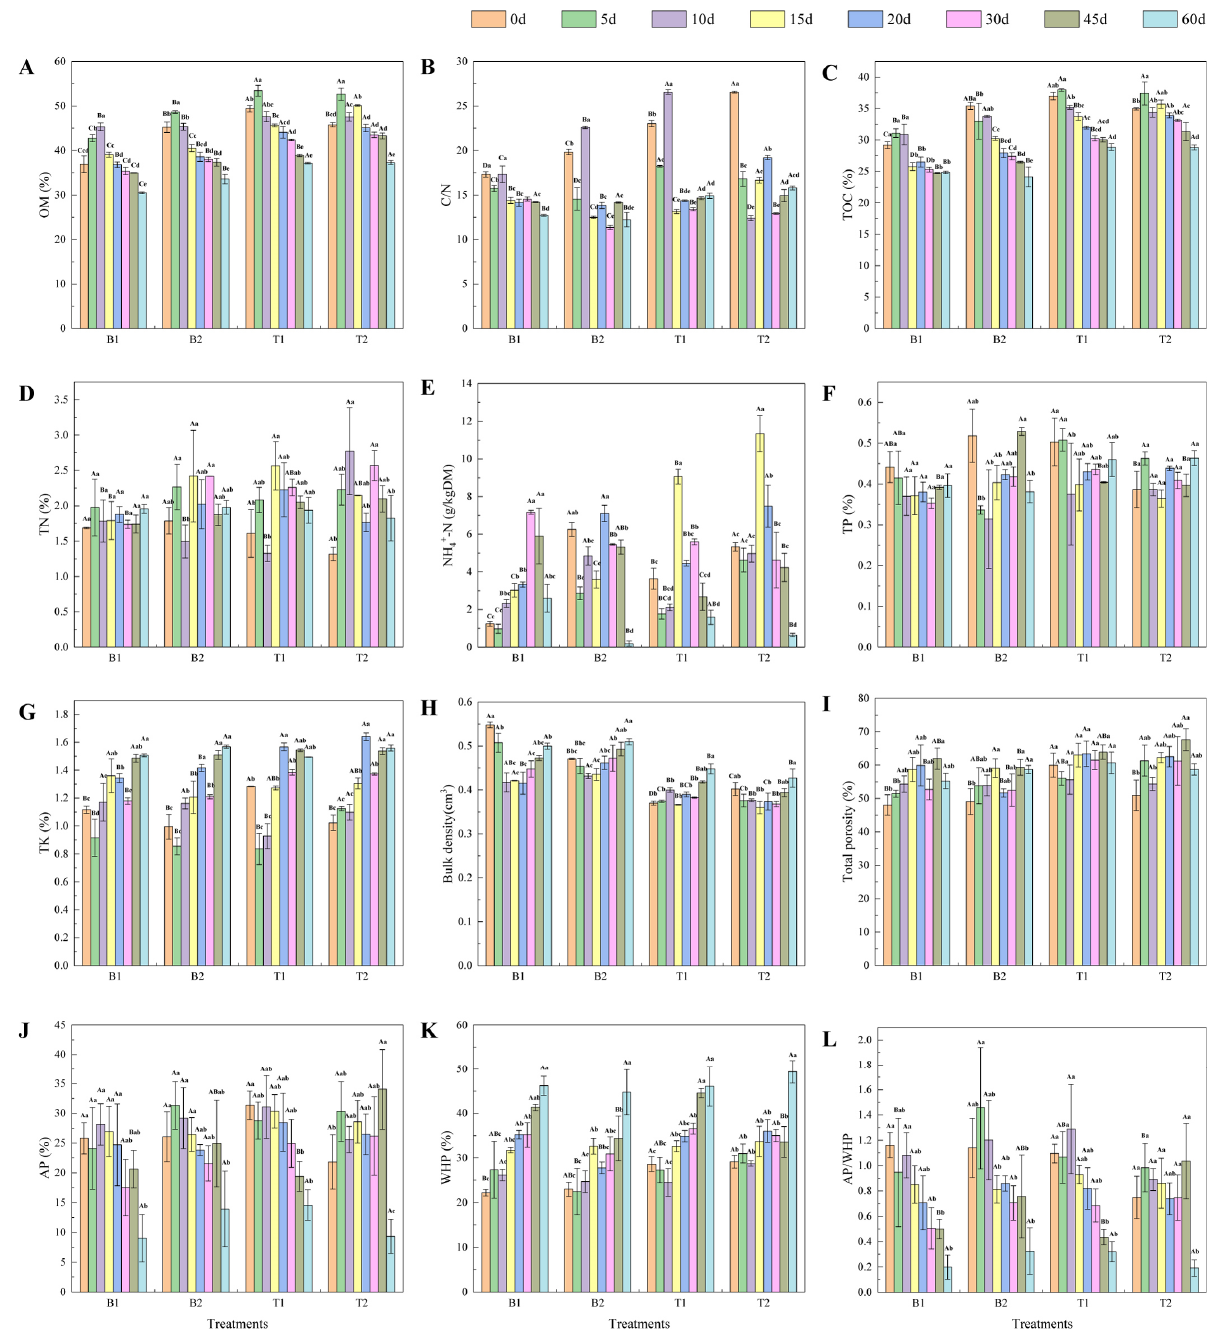
Figure 3. Variations of physicochemical parameters during composting. ( A ) organic matter (OM), ( B ) C: N, ( C ) Total organic carbon (TOC), ( D ) Total nitrogen (TN), ( E ) NH4 + -N concentration, ( F ) Total phosphorus (TP), ( G ) Total potassium (TK), ( H ) bulk density, ( I ) total porosity, ( J ) aeration porosity (AP), ( K ) water-holding porosity (WHP), ( L ) AP/WHP. B1, V mushroom residue :V sheep manure = 5:1, with CMA inoculation; B2, V mushroom residue :V sheep manure = 5:1, without inoculation; T1, V mushroom residue :V sheep manure = 9:1, with CMA inoculation; T2, V mushroom residue :V sheep manure = 9:1, without inoculation. The significant difference within the same group (different days of the same treatment) is represented by lowercase letters, while the significant difference among the groups (different treatments on the same day) is represented by uppercase letters ( p <